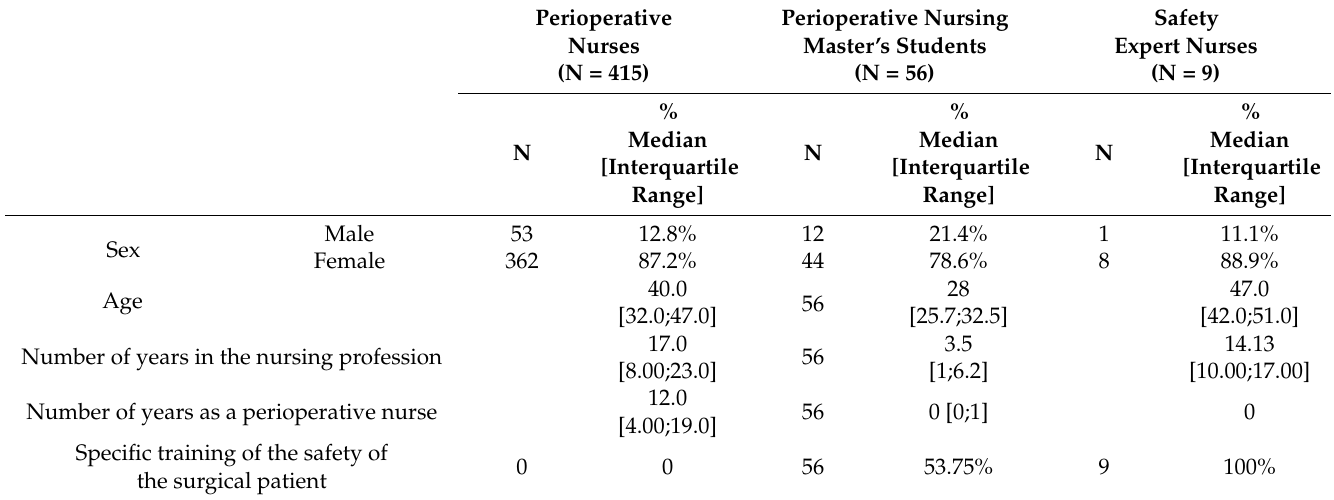
Table 2. This is a table of the sociodemographic characteristics of the perioperative nurses, Periopera- tive Nursing Master’s students, and nurses who are experts in